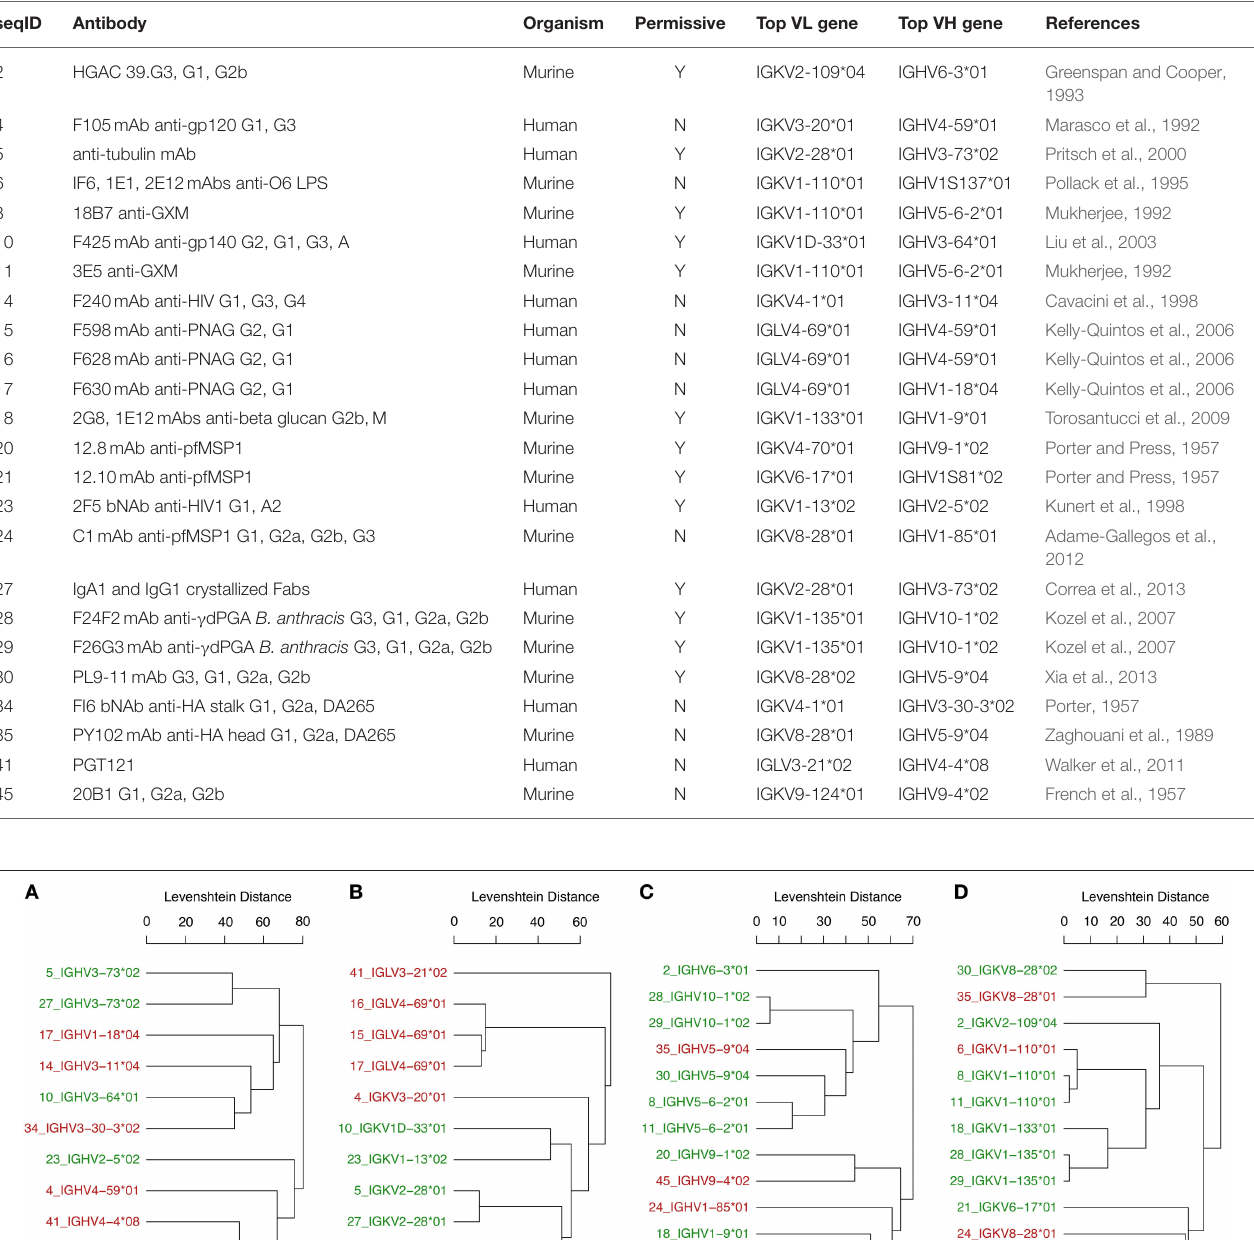
TABLE 2 | Unique antibodies with variable-region-identical isotype-switch variants and identifiable amino acid sequences.